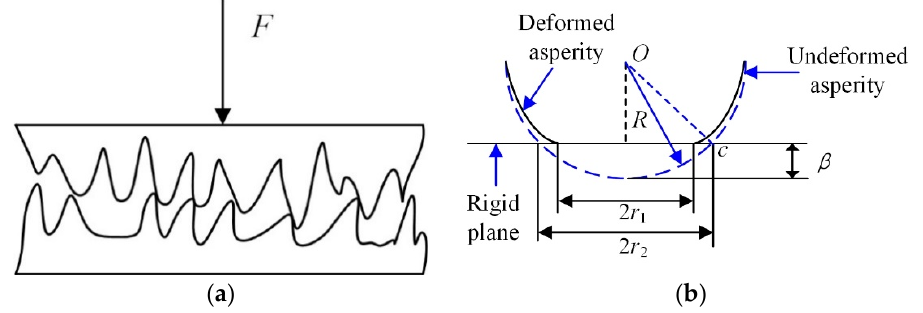
Figure A1. ( a ) is the sketch of rough surfaces in contact and ( b ) is the equivalent surface